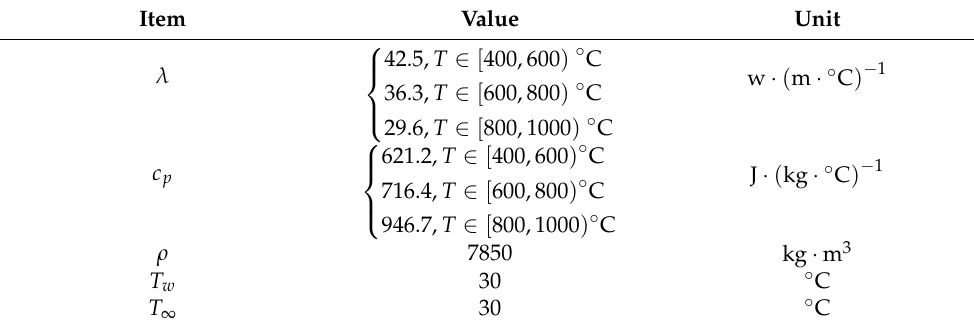
Table 1. Q235b strip steel thermophysical